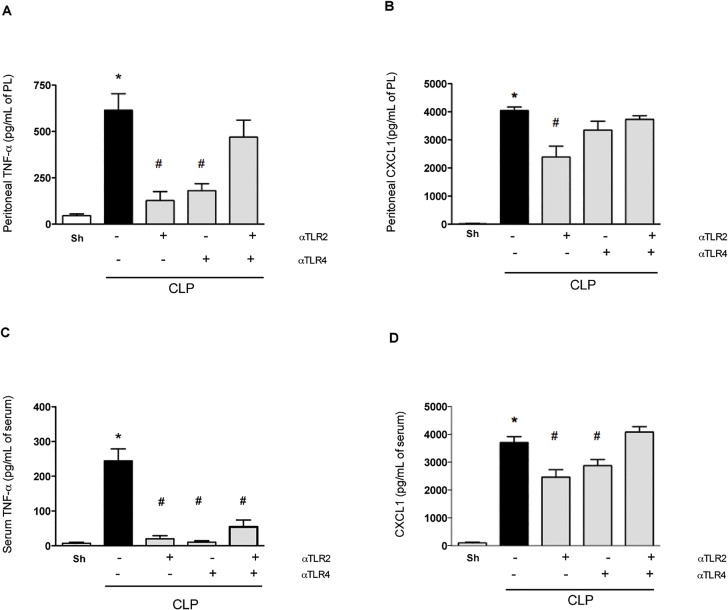
Blockade of either TLR2 or TLR4 reduces TNF-α and CXCL1 levels after polymicrobial sepsis.Mice were pre-treated with individual or combined anti-TLR2 or anti-TLR4 antibodies (45 minutes before the CLP procedure). Single treatment resulted in lower levels of TNF-α and CXCL1 (A and B, respectively) in the peritoneal cavity (PL: peritoneum lavage) and in serum (C and D, respectively) 6 hours after sepsis compared to the negative control isotype IgG antibody treatment (black bar). The combined treatment with both anti-TLR2 and anti-TLR4 presented similar response compared to negative isotype IgG treated-group. * p<0.05 between the CLP and Sham groups. # p<0.05 between the antibody treatment groups and negative control isotype IgG treated-group. Antibody dose (1 mg/animal). Used 6 animals/group, except isotype IgG antibody treated group (n = 10).